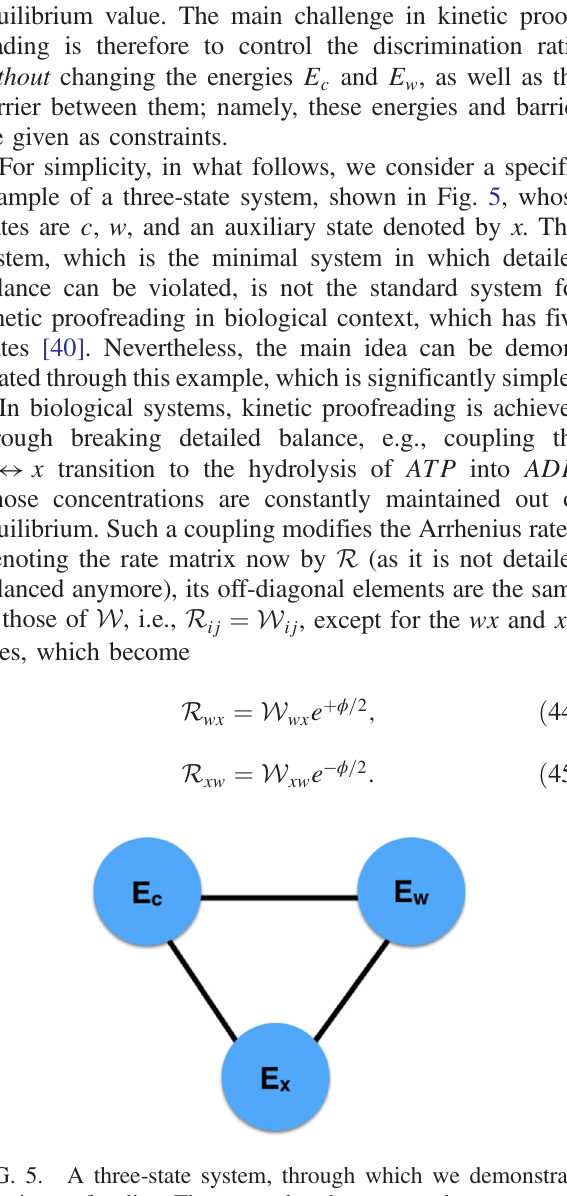
FIG. 5. A three-state system, through which we demonstrate kinetic proofreading. The system has three states: the correct state c , the wrong state w , and the auxiliary state x . Each state is associated with internal energies E c , E w , and E x , respectively. Between any two states, there is a (symmetric) barrier, B B B B B B cw ¼ wc , cx ¼ xc , and wx ¼ xw . The transition rates between the different states are given by the corresponding Arrhenius